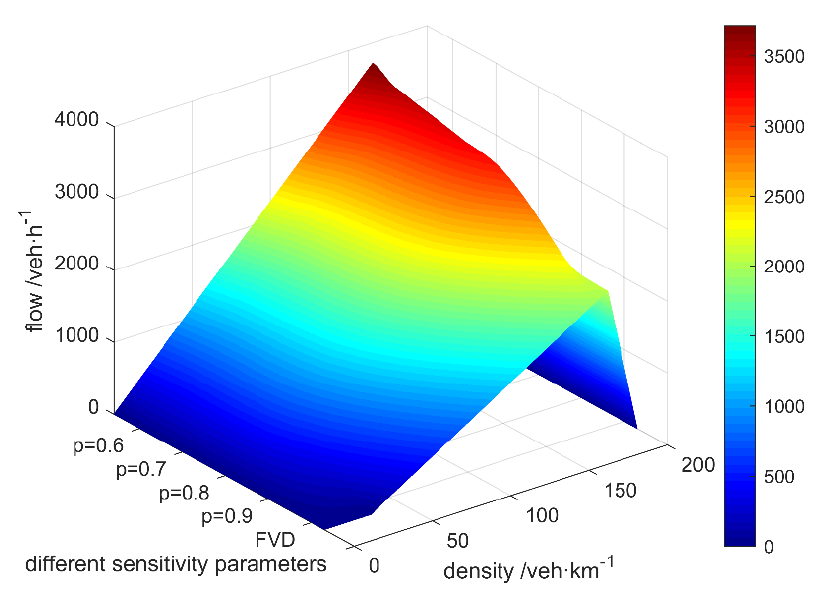
Figure 5. The volume–density surface.